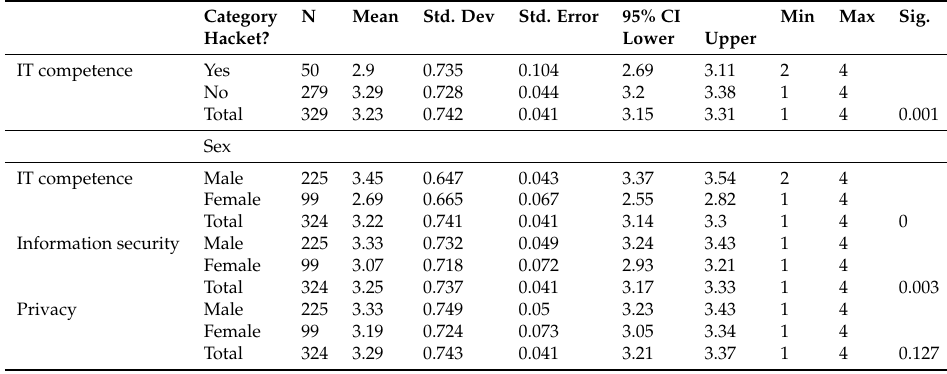
Table 8. Self-rating differences between the self-assessment